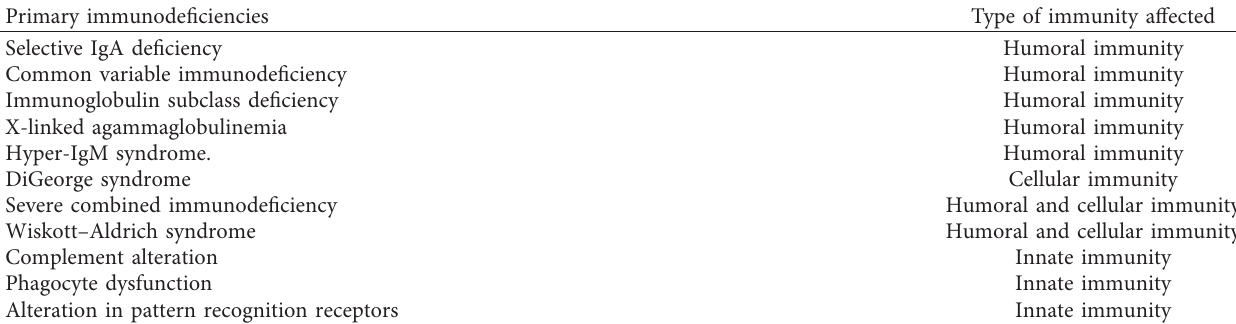
Table 1: Most common primary immunodeficiencies and type of associated immune